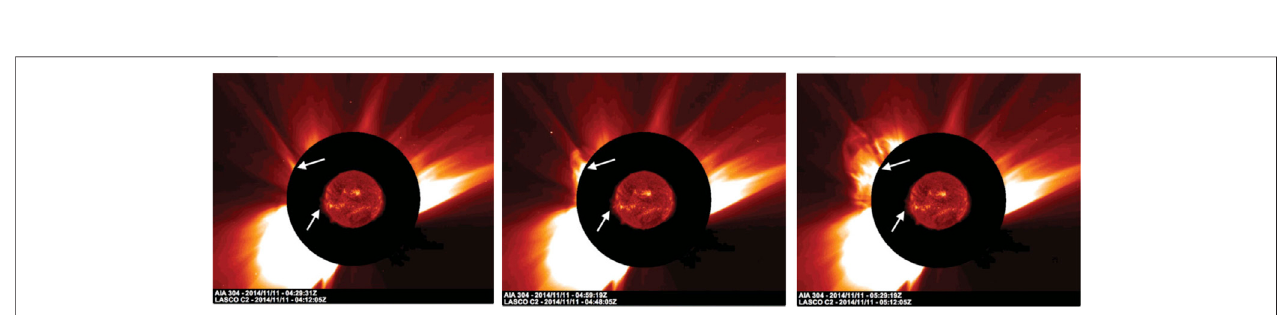
FIGURE 7 | The CME process recored by the SOHO/LASCO C2 at 04:29, 04:59 and 05:29UT after the radio burst. The CME and radio burst locations are indicated by the arrows, respectively.